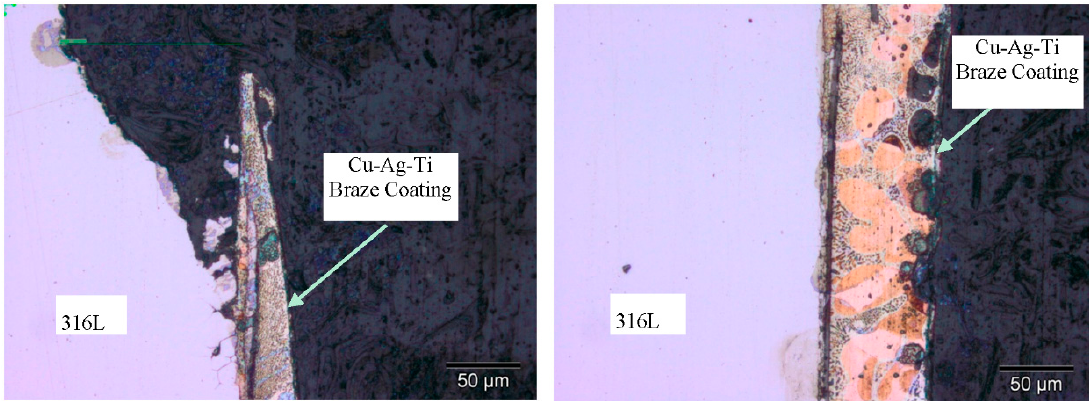
Figure 10. Cross sectioned 316L stainless steel sample with a Cu-Ag-Ti braze alloy coating following exposure for seven days in 0.6 M NaCl followed by a potentiodynamic scan.